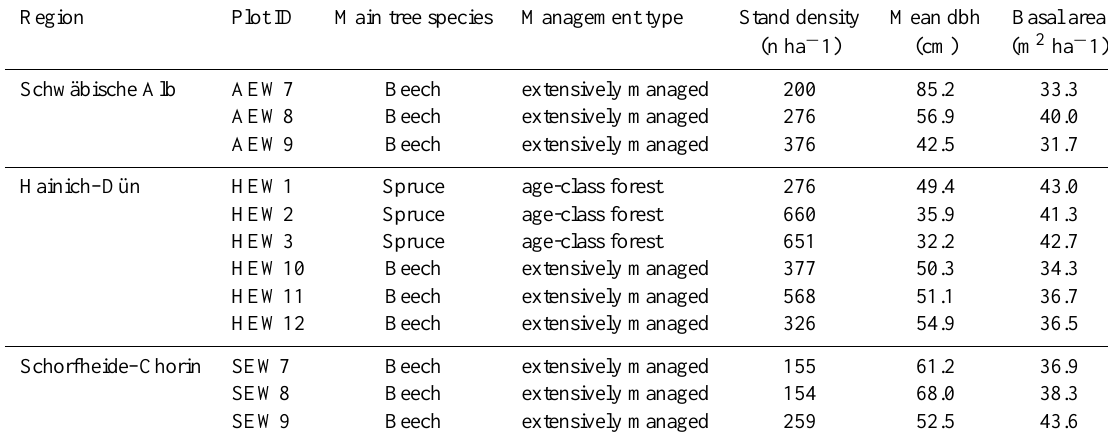
Table 2. Stand structural properties and management type of the study plots (dbh is the tree diameter at breast height; data from Schwarz et al., 2014).